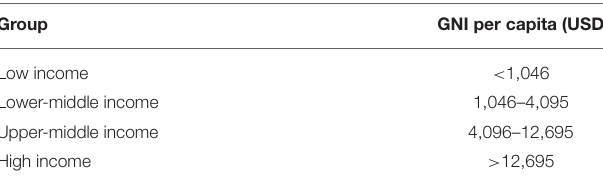
TABLE 1 | Definitions of World Bank income level classifications 2021–2022 (World Bank,